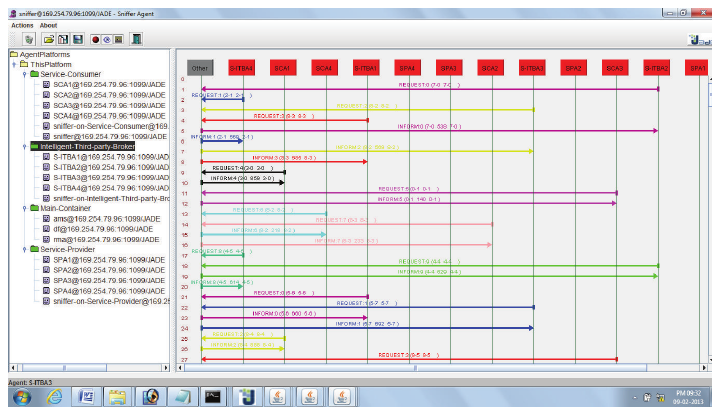
Figure 4: Visualization of negotiation process using sniffer